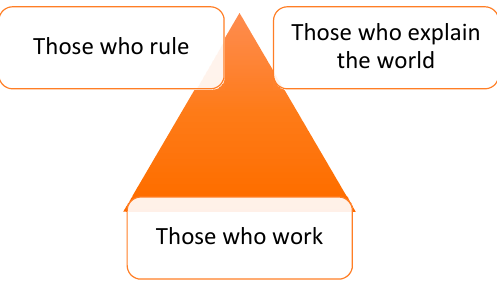
Those who work Figure 1. Diagram of the social order. Figure 1. Diagram of the social